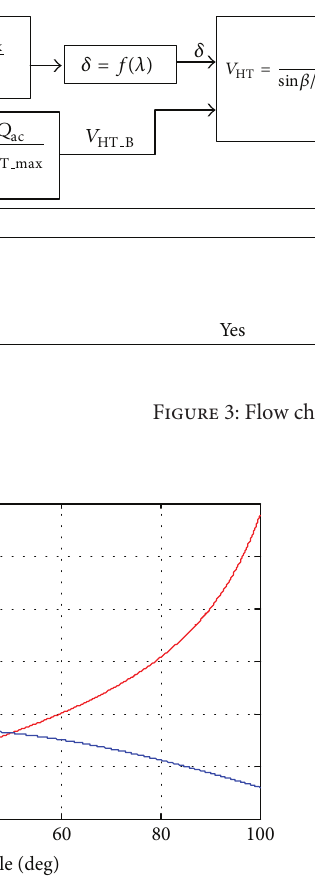
/𝑉 and 𝜆 changecorrespondingtodifferent B HT